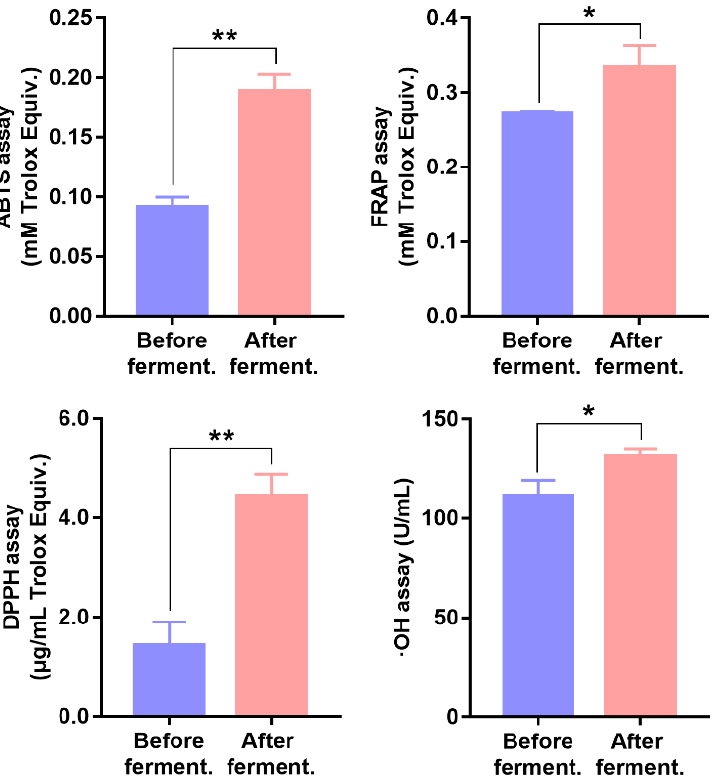
Figure 3. Antioxidant capacity of pre-fermented and post-fermented working solutions of cecal contents group (compared with intestinal pre-fermented working solution; * p < 0.05, ** p < 0.01).